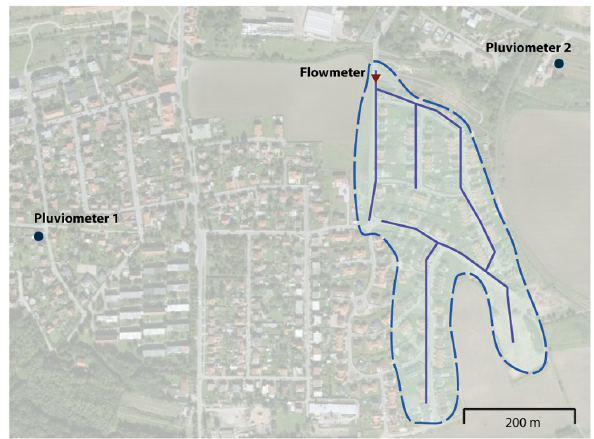
Fig. 2. Aerial photo of our Sadová case study catchment. The map shows the layout of the main stormwater conduits and the location of the rain gauges and the